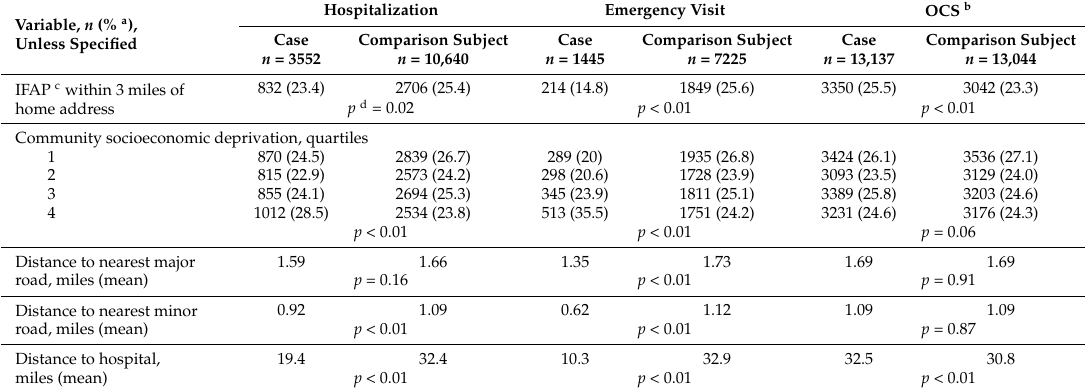
Table 2. Place-level descriptive statistics of cases and comparison subjects by exacerbation